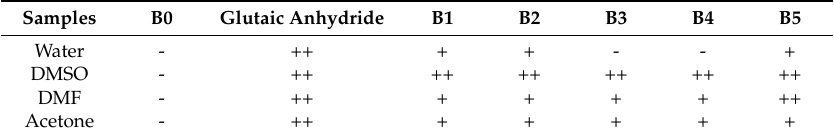
Table 2. The solubility of bagasse samples in water and common organic solvents.